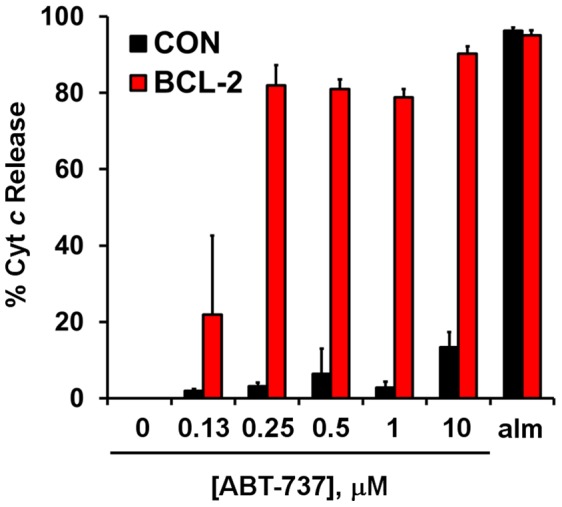
MCF10A BCL-2 mitochondria are selectively sensitive to ABT-737-induced cytochrome c release.Cyt c was quantified by ELISA in the medium and cell lysate after a 28 min incubation of permeabilized cells with vehicle, ABT-737 (as indicated), or alamethicin (alm, 80 µg/ml). Succinate (5 mM, in the presence of rotenone, 0.5 µM), ADP (1 mM), and K2HPO4 (3.6 mM) were present to support mitochondrial respiration during the treatment. Results are expressed as % cyt c released into the medium compared to the total cyt c that was quantified (mean ± SD, n = 3). Cyt c was not detectable in the medium of permeabilized cells treated with vehicle.